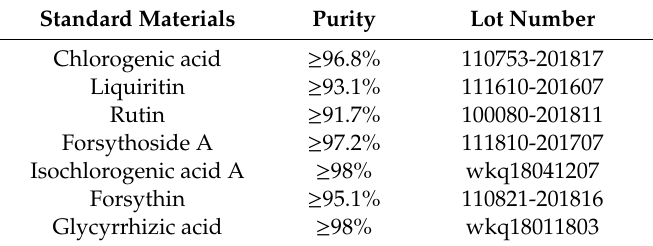
Table 12. Information on the standard